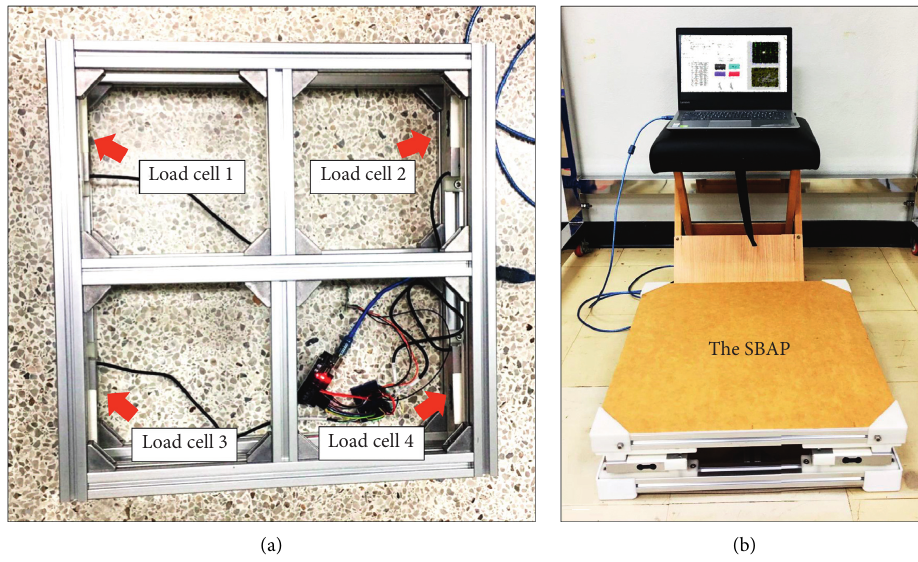
Figure 1: The standing balance assessment posturography (SBAP): (a) position of load cells; (b) overview of SBAP.